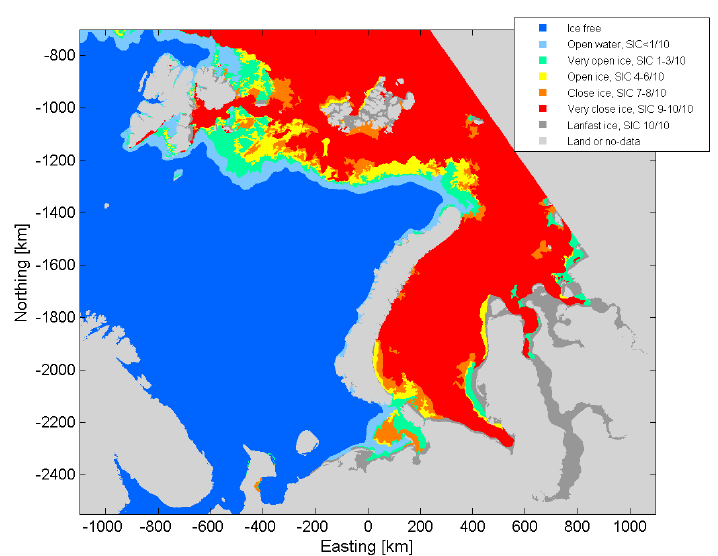
Figure 5. METNO ice chart on 12 May 2016. The original ice chart was resampled to the study area shown in Figure 1 with 250 m pixel size. The original chart does not cover the northeast area of the Kara Sea.